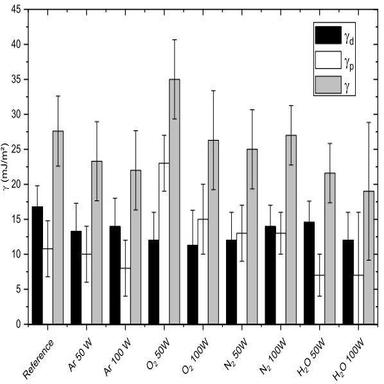
Surface free energy (γ) and its polar (γp) and dispersive (γd) components of the single CF strand for different gasses and applied powers with a fixed exposure time (5 min).